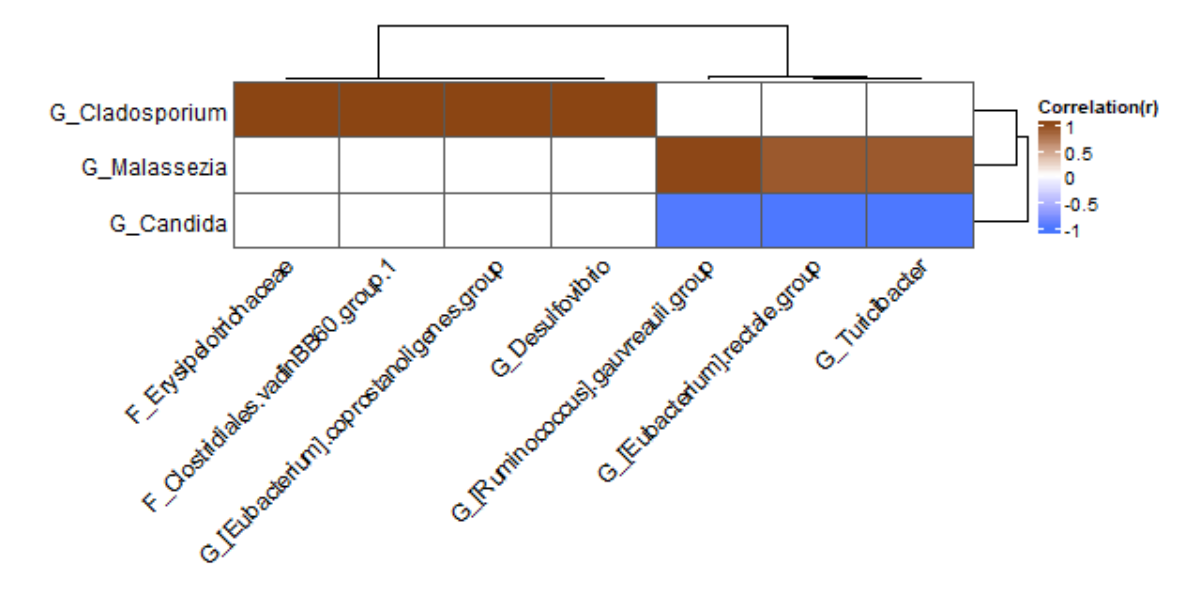
Figure 10. Heatmap at genus level for fungicide samples; only genera present in at least 20% of samples were included.